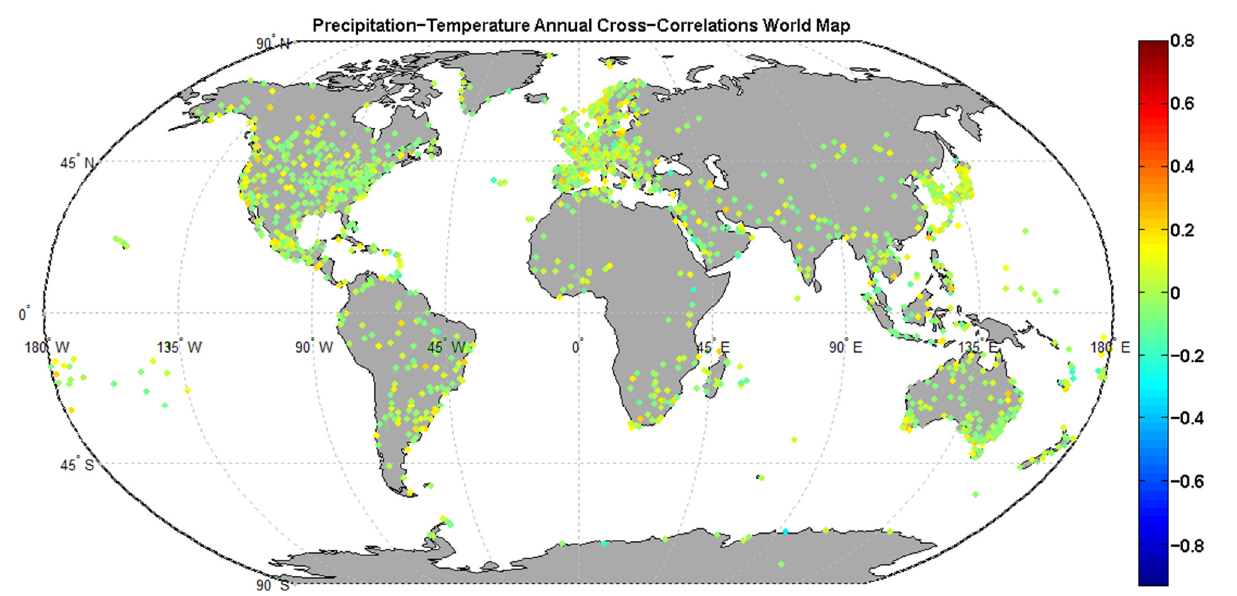
Figure 12. Cross–correlations between global ‐ scale precipitation and temperature records of annual resolution. Results are color coded from red (strong positive) to blue (strong negative) cross–corre ‐ lations.